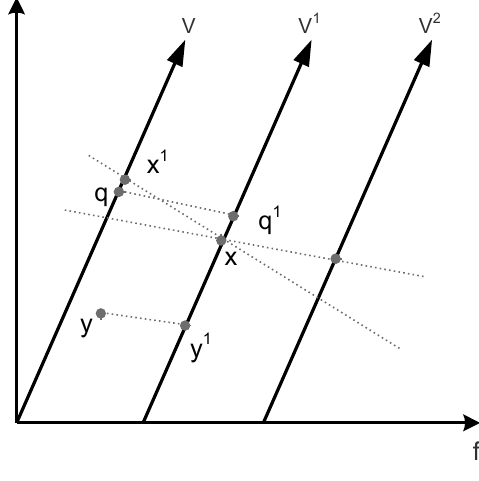
Figure 2. D-dominance example diagram.